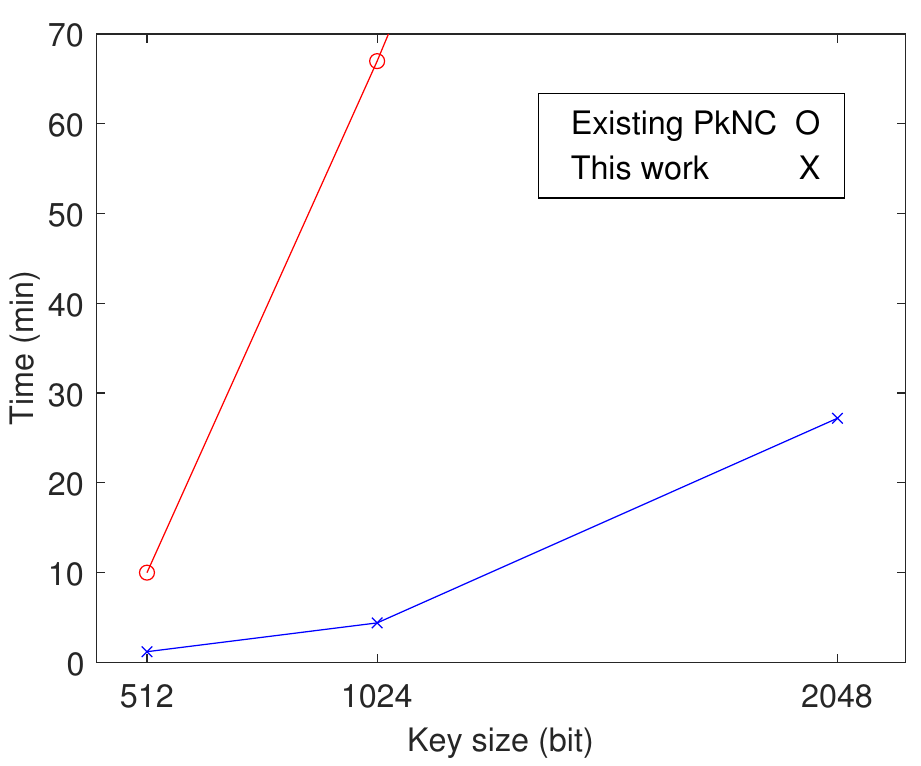
Figure 4. Running time comparison of our P k NC and the existing P k NC [11] for key size (bit).